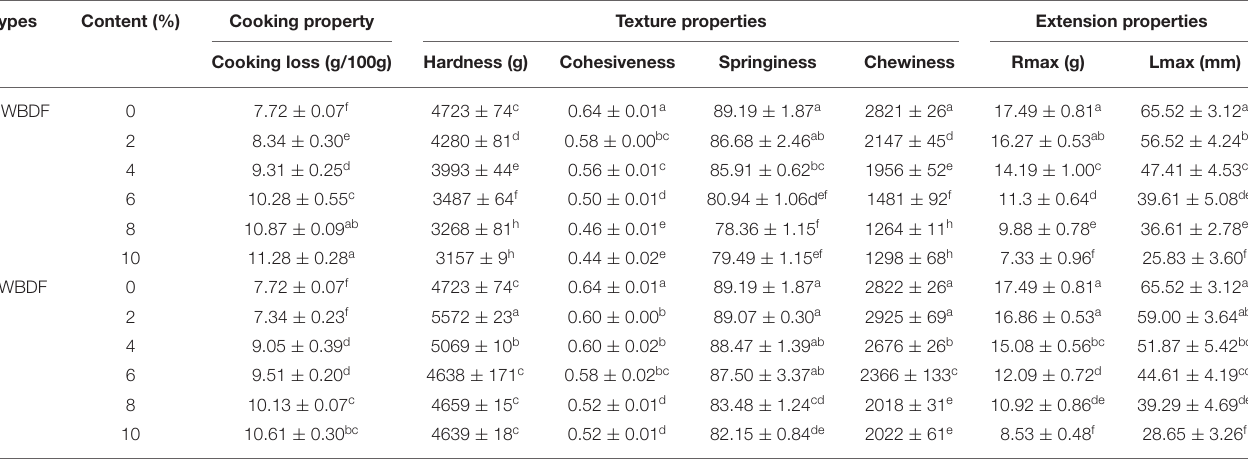
TABLE 2 | Effect of UWBDF/FUWBD addition on cooking and texture properties of noodles.